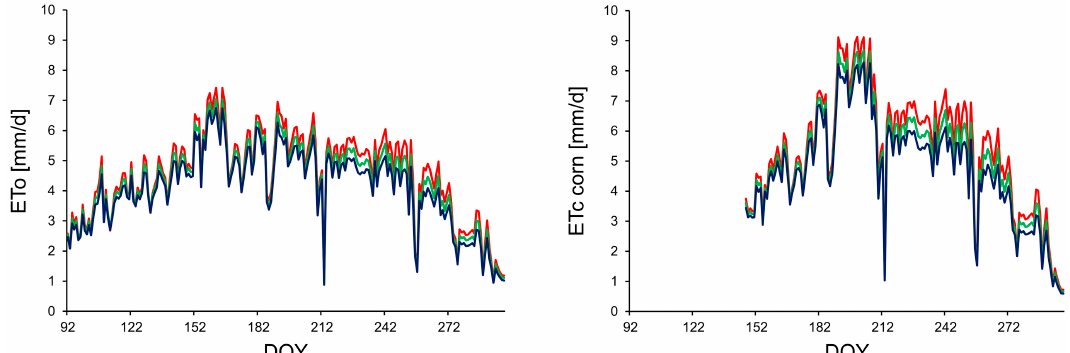
Figure 3. ETo ( left ) and ETc of corn ( right ) under open field conditions (in red), under the assumption of reduction of wind speed by 20% (in green), and under the set of assumptions of reduction of wind speed by 35%, temperature reduction by 1 °C, and increase of air humidity by 0.05 (in blue). DOY refers to n th day of the year, i.e., data on the x -axis start on 1 April (DOY 92) and end on 24 October. ETo reaches its maximum in June (7–13 June) with over 7 mm/d. During these days, air humidity